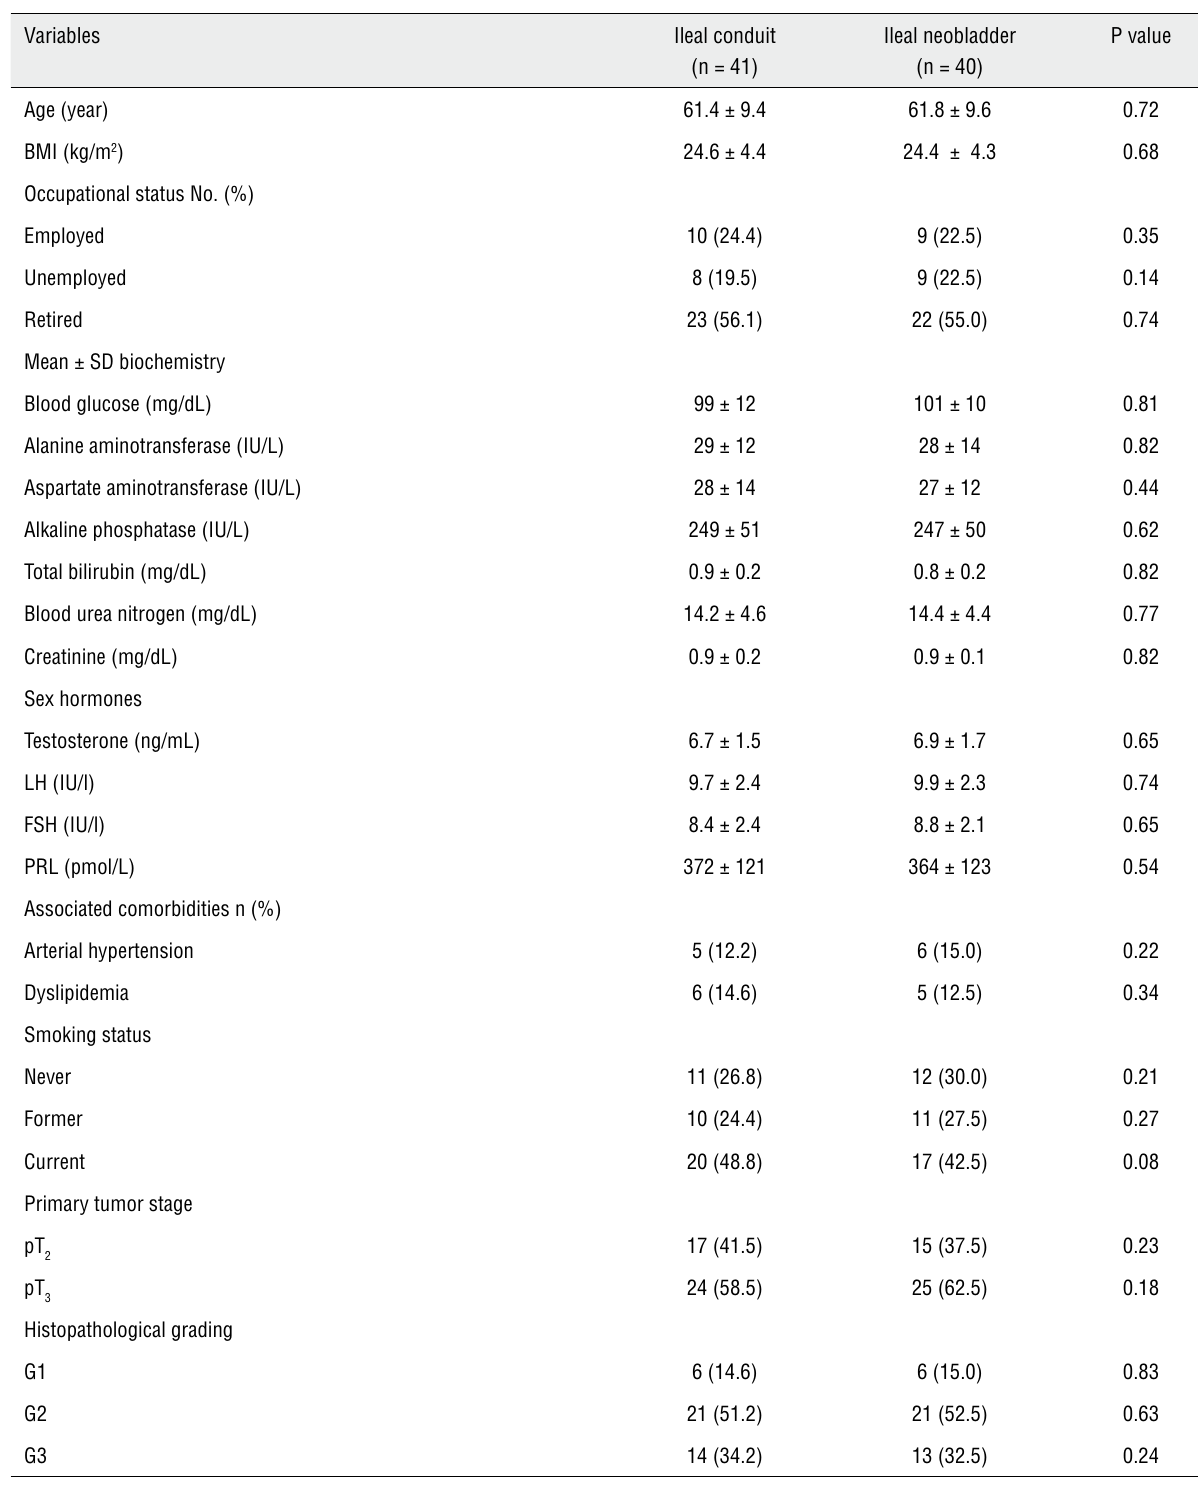
Table 1 - Distribution of selected demographic and clinical variables among the study